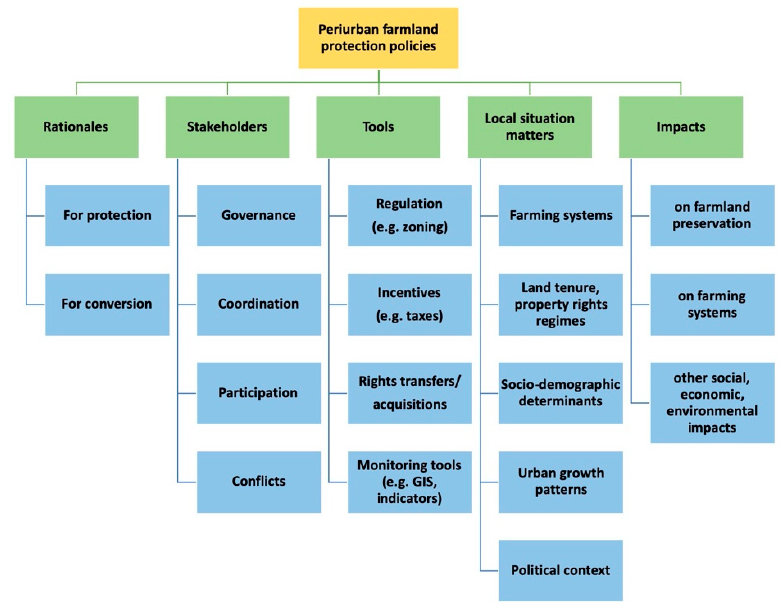
Figure 1. Flow diagram of the selection process.